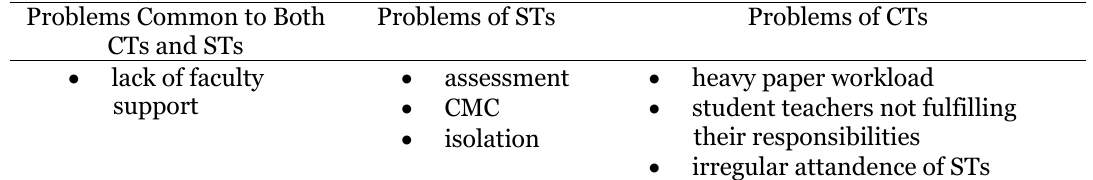
Problems of Problems of Student Teachers (STs) and Cooperating Teachers (CTs) During